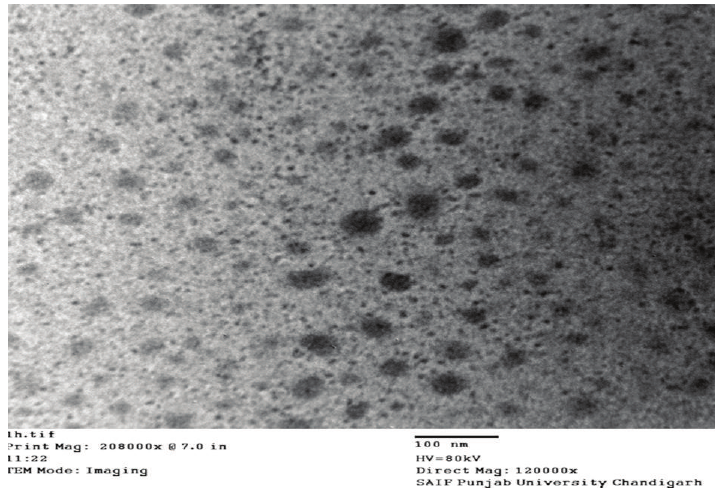
Figure 7: Transmission electron micrograph (TEM) image of optimized formulation (SP2).